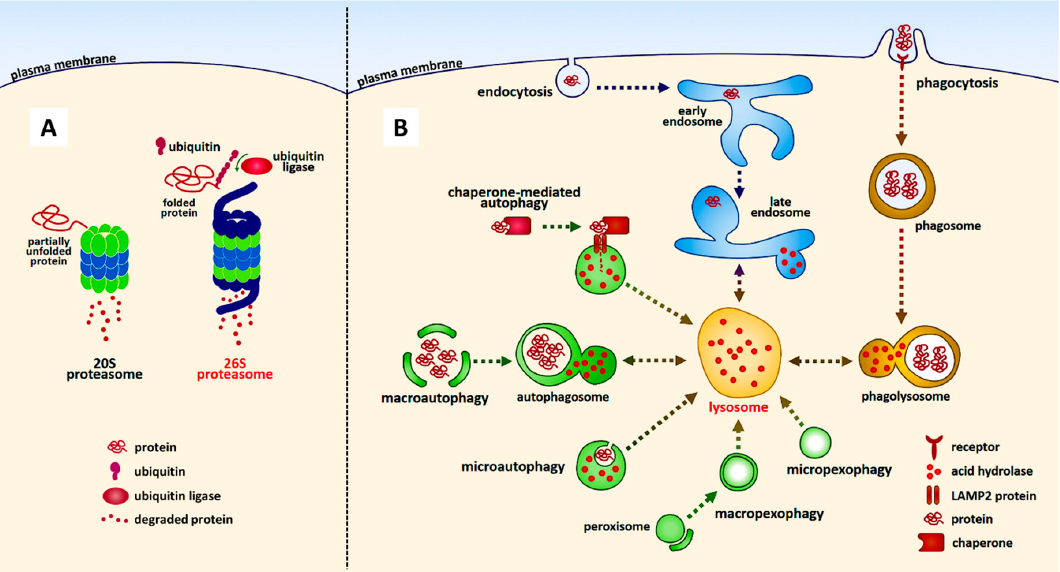
Figure 1. The representative protein degradation pathways in eukaryotic cells. Proteasome-dependent ( A ) and lysosome-dependent ( B ) pathways are shown. Note that not all the degradation pathways are illustrated in the figure.